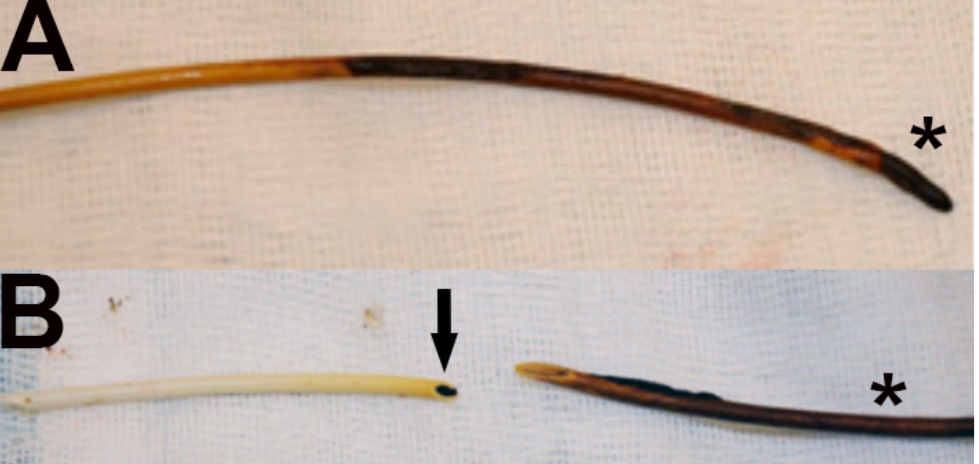
Figure 2: Fecally stained peritoneal catheter. * indicates the distal end (A); the peritoneal catheter was divided after removal (B); the arrow indicates intraluminal